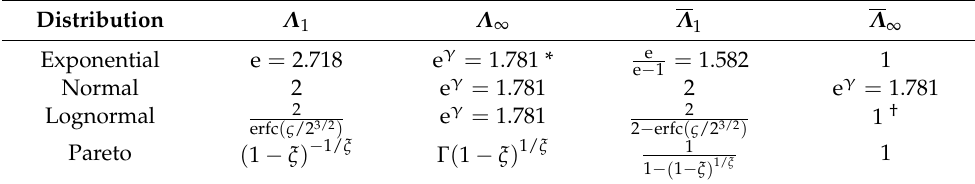
Table 3. Characteristic Λ values for the distributions of Table 2.